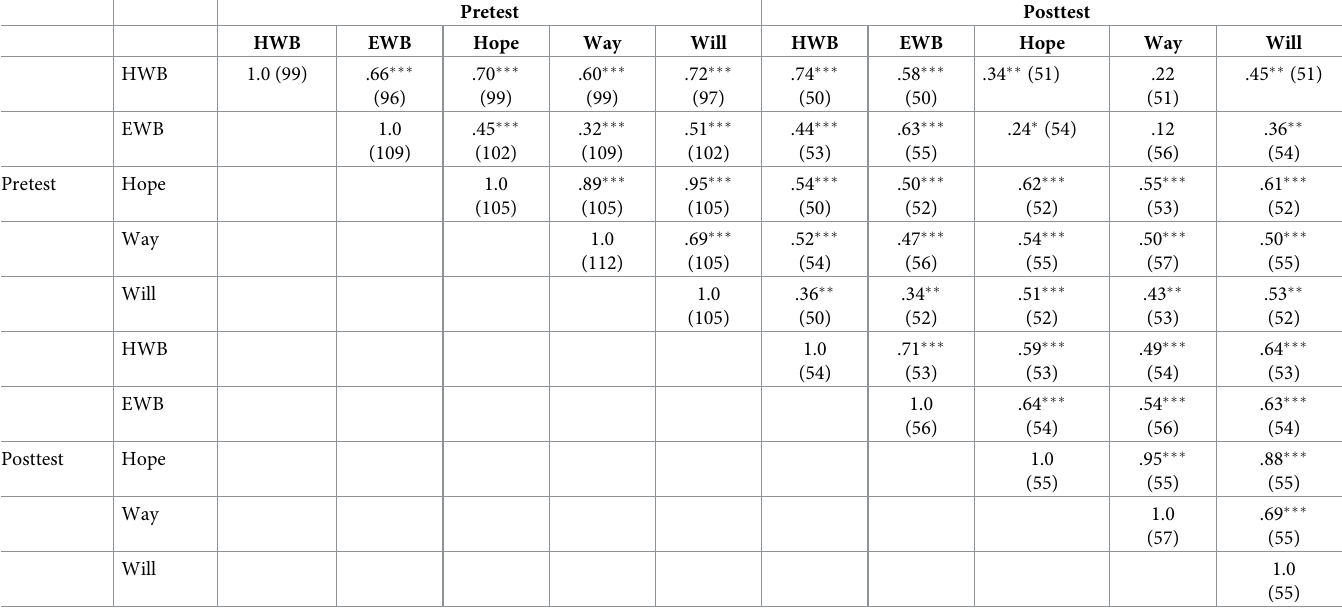
Table 2. Correlations among pretest and posttest wellbeing and hope